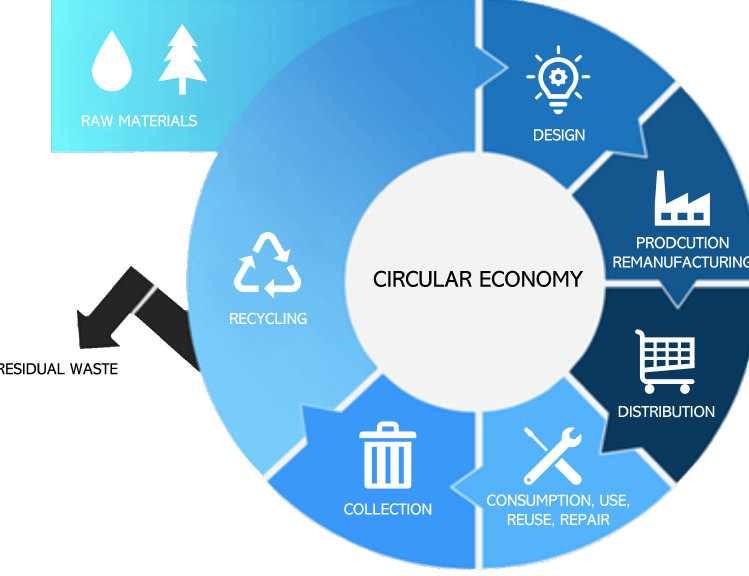
Figure 3. Diagram of circular